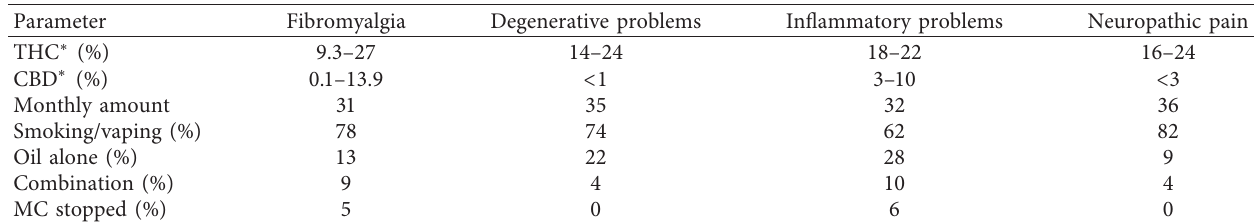
Table 2: Characteristics of MC use and THC and CBD contents among the different groups of patients.